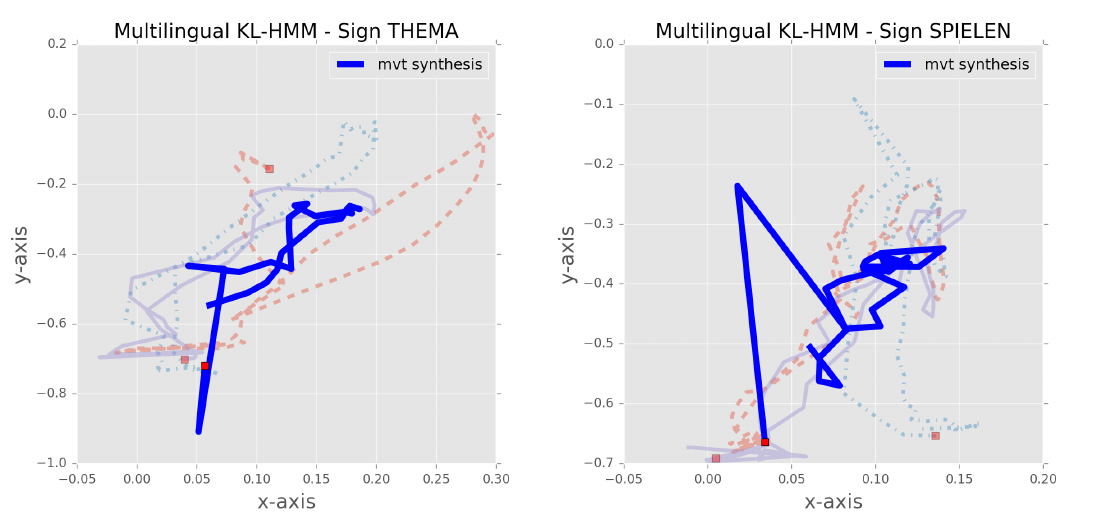
Figure 8. Movement synthesis of the dominant hand for the well-recognized sign, THEMA ( left ), and the poorly-recognized sign, SPIELEN ( right ), using the Gaussian distribution sequence computed from the KL-HMM system using the TSL HospiSign subunits. The red squares are the starting